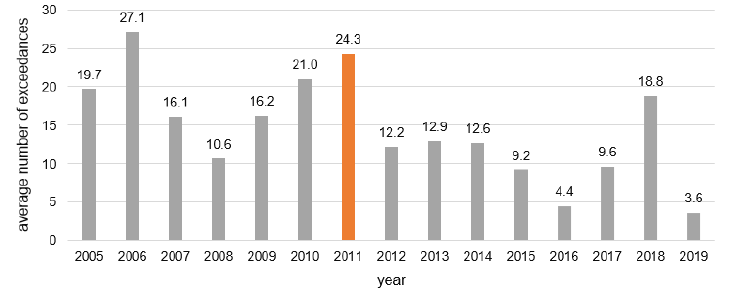
Figure 2. Average number of exceedances per active station of the daily mean limit value of 50µgm − 3 set by the directive 2008/50/EC on ambient air quality and cleaner air for Europe